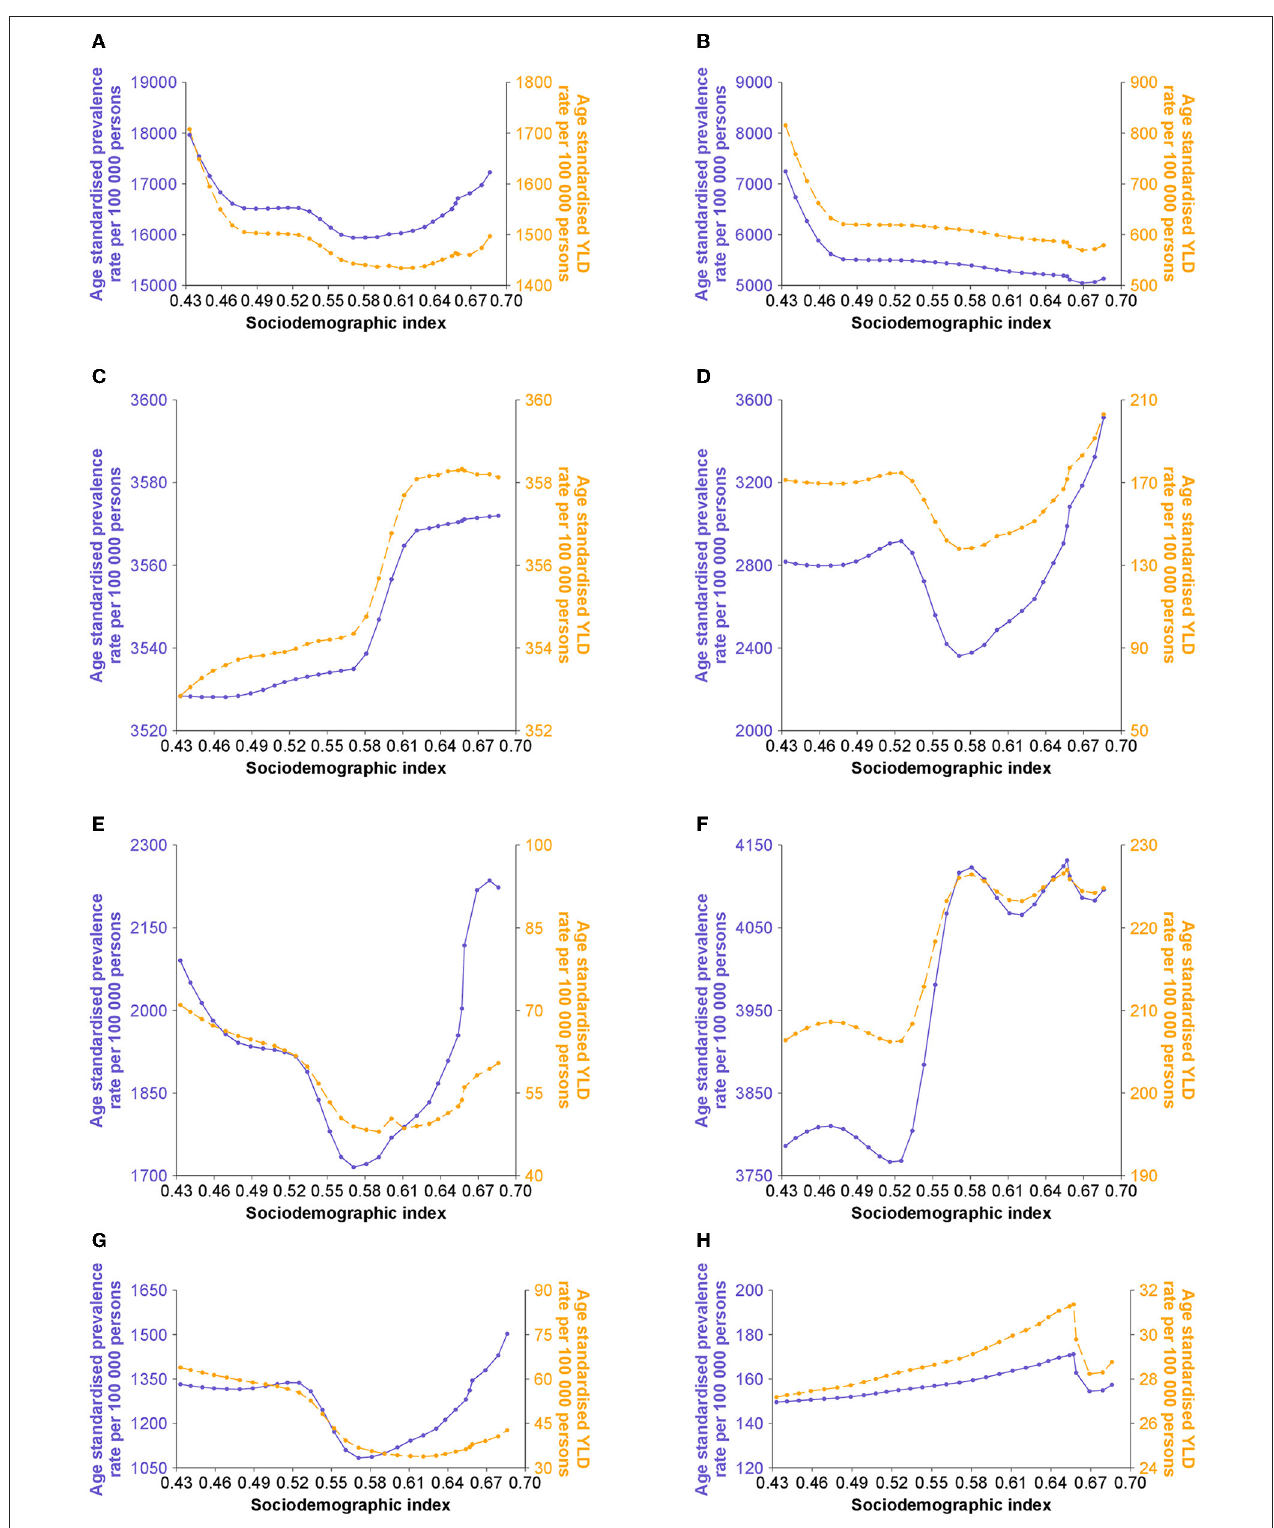
FIGURE 2 | Age-standardized rates of musculoskeletal rehabilitation needs by sociodemographic index in China. (A) Musculoskeletal disorders. (B) Low back pain. (C) Neck pain. (D) Fractures. (E) Other injuries. (F) Osteoarthritis. (G) Amputation. (H) Rheumatoid arthritis.